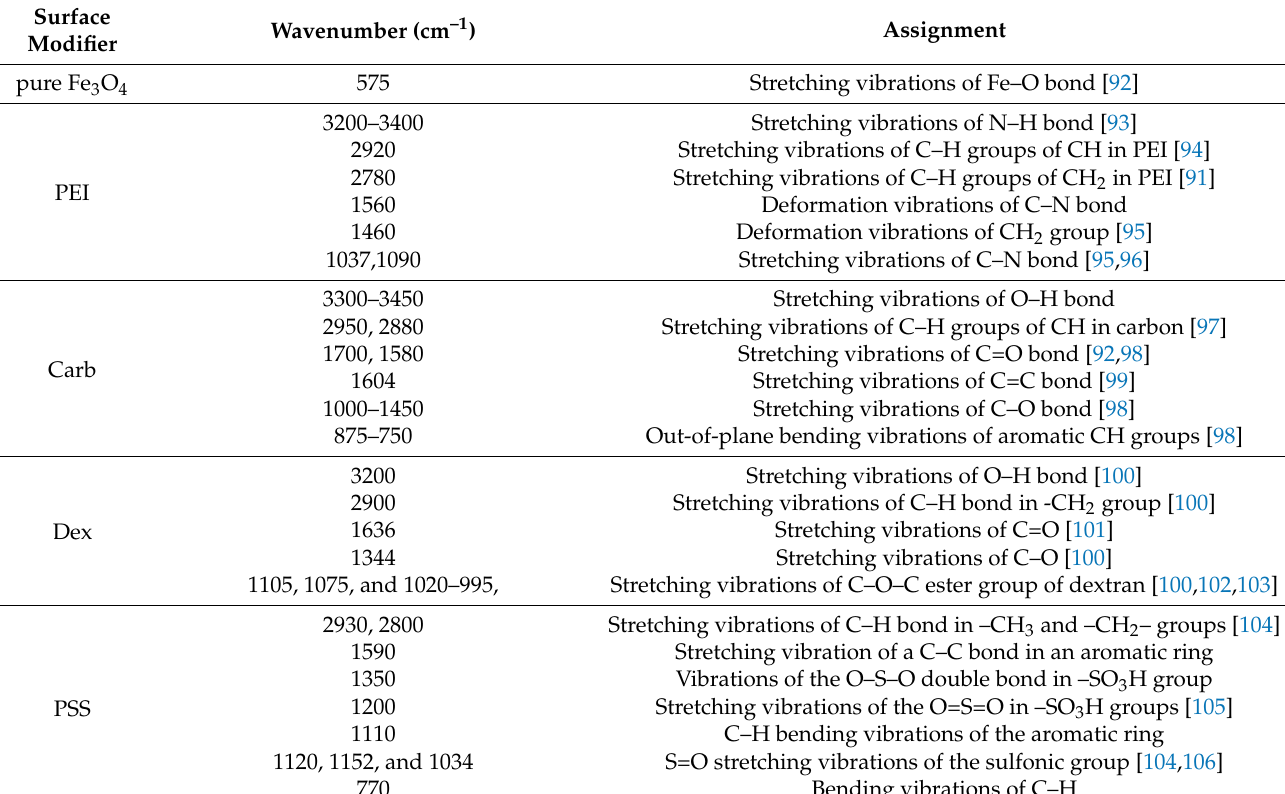
Table 1. IR band assignment for modified magnetite particles.